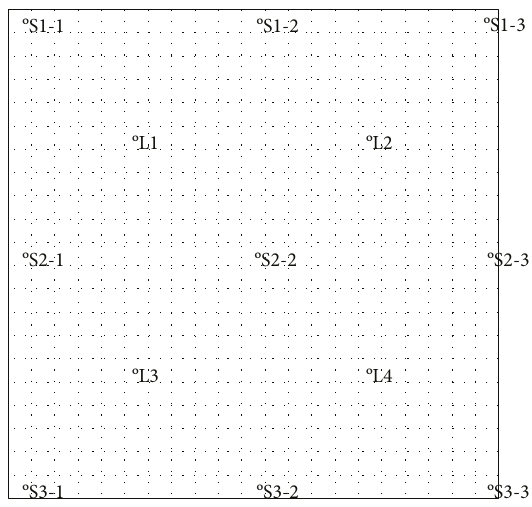
Figure 4: The distribution diagram of well